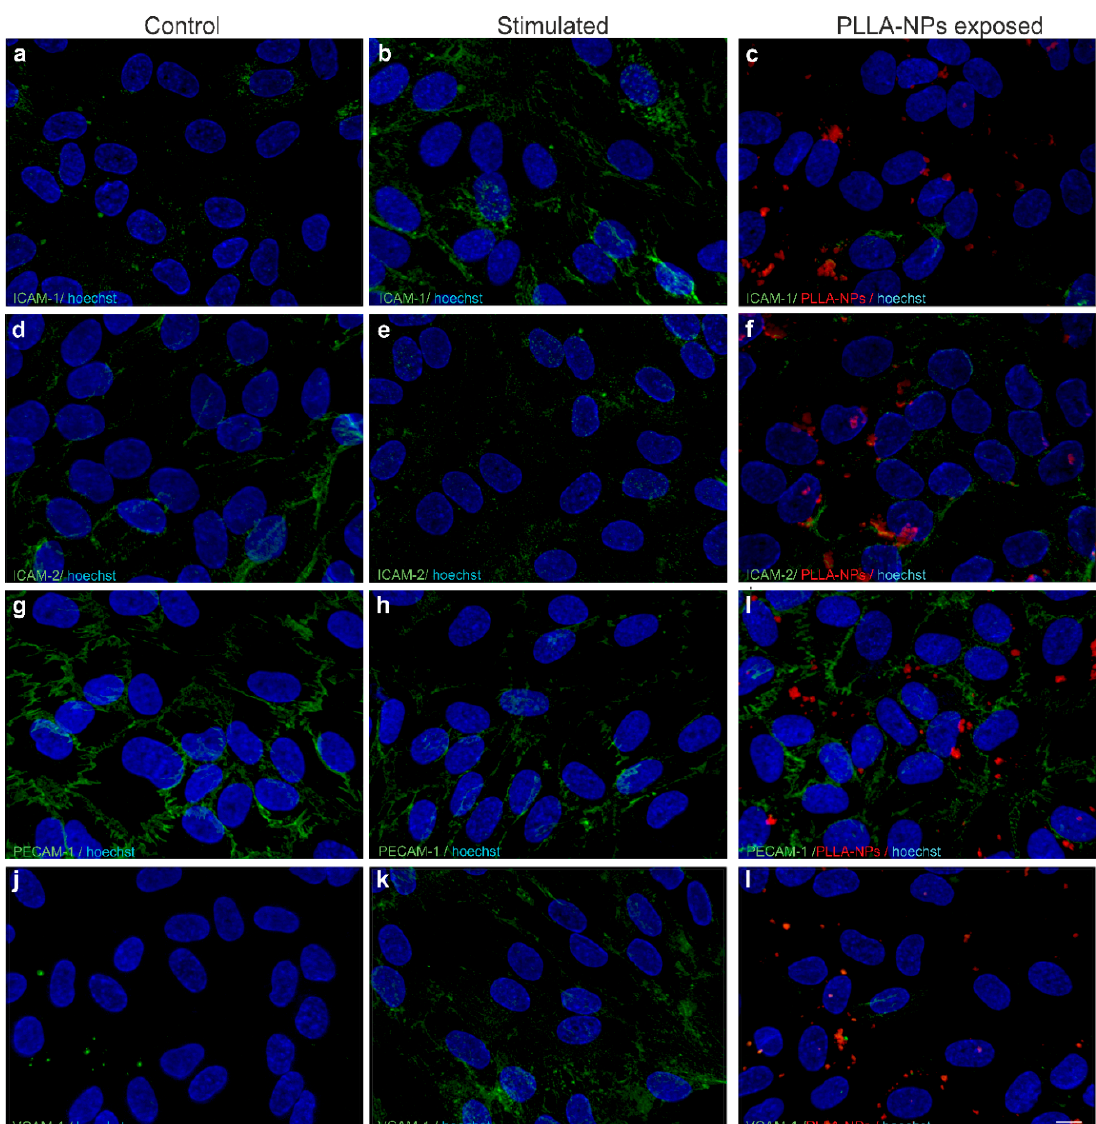
Figure 5. Representative microscopic images of effects of polymer ‐ coated NPs on the expression of ICAM ‐ 1( a – c ), ICAM ‐ 2 ( d – f ), PECAM ‐ 1 ( g – i ) and VCAM ‐ 1 ( j – l ) (green). Non ‐ exposed cells were used as control ( a , d , g , j ). Stimulation with a combination of TNF ‐α (1 ng/mL) and IFN ‐γ (1 ng/mL) for 16 h, starting on DIV6 ( b , e , h , k ) was carried out as positive controls. hBLECs were exposed to PLLA ‐ NPs for 2 h on DIV7 at a concentration of (24.9 μ g/mL) ( c,f , i , l ). Cell nuclei were counterstained with Hoechst (blue). Scale bars: 10 μ m in each plane.